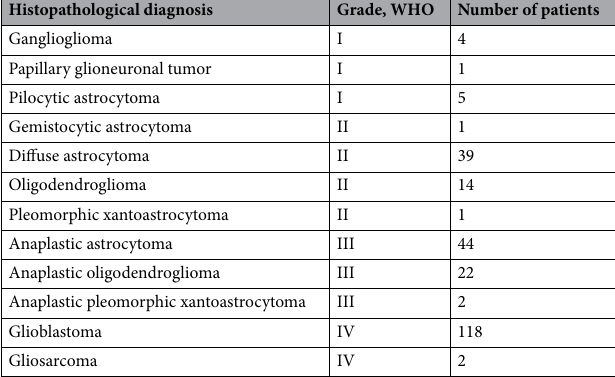
Table 1. Histopathological diagnosis in patients of the studied group (WHO,